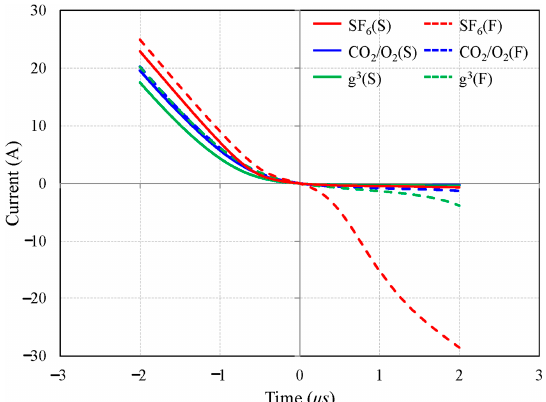
Figure 5. Comparison of interrupting current behaviors based on current zero-cross time according to interrupting success and failure of SF 6 , CO 2 /O 2 , and g 3 gases.